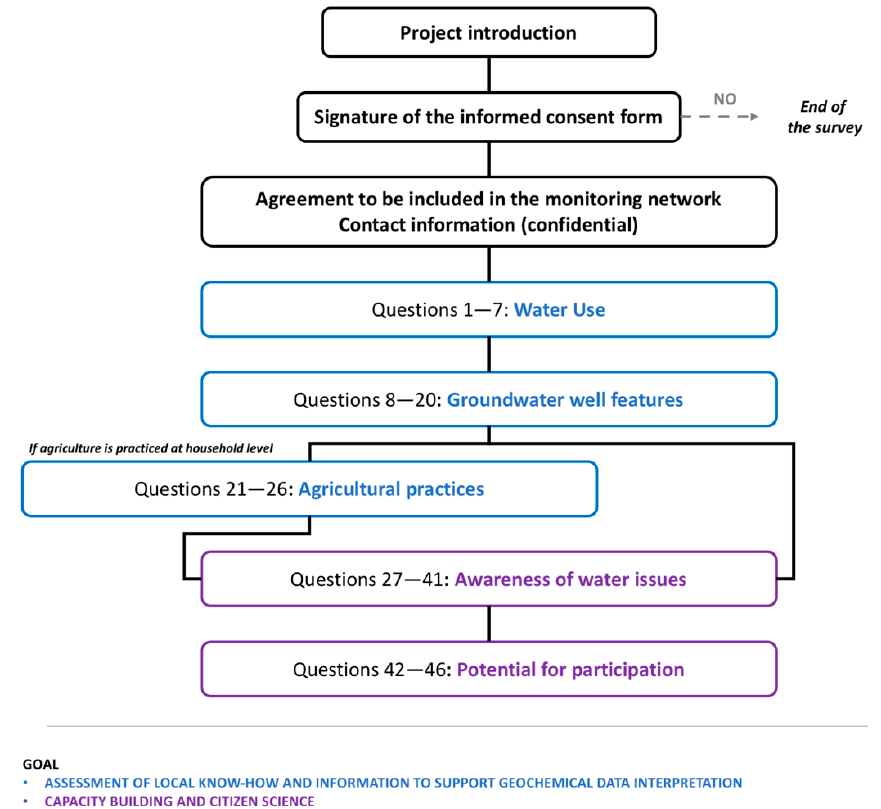
Figure 2. Survey scheme and sectioning. All questions and answer options are reported in the Supplementary materials.